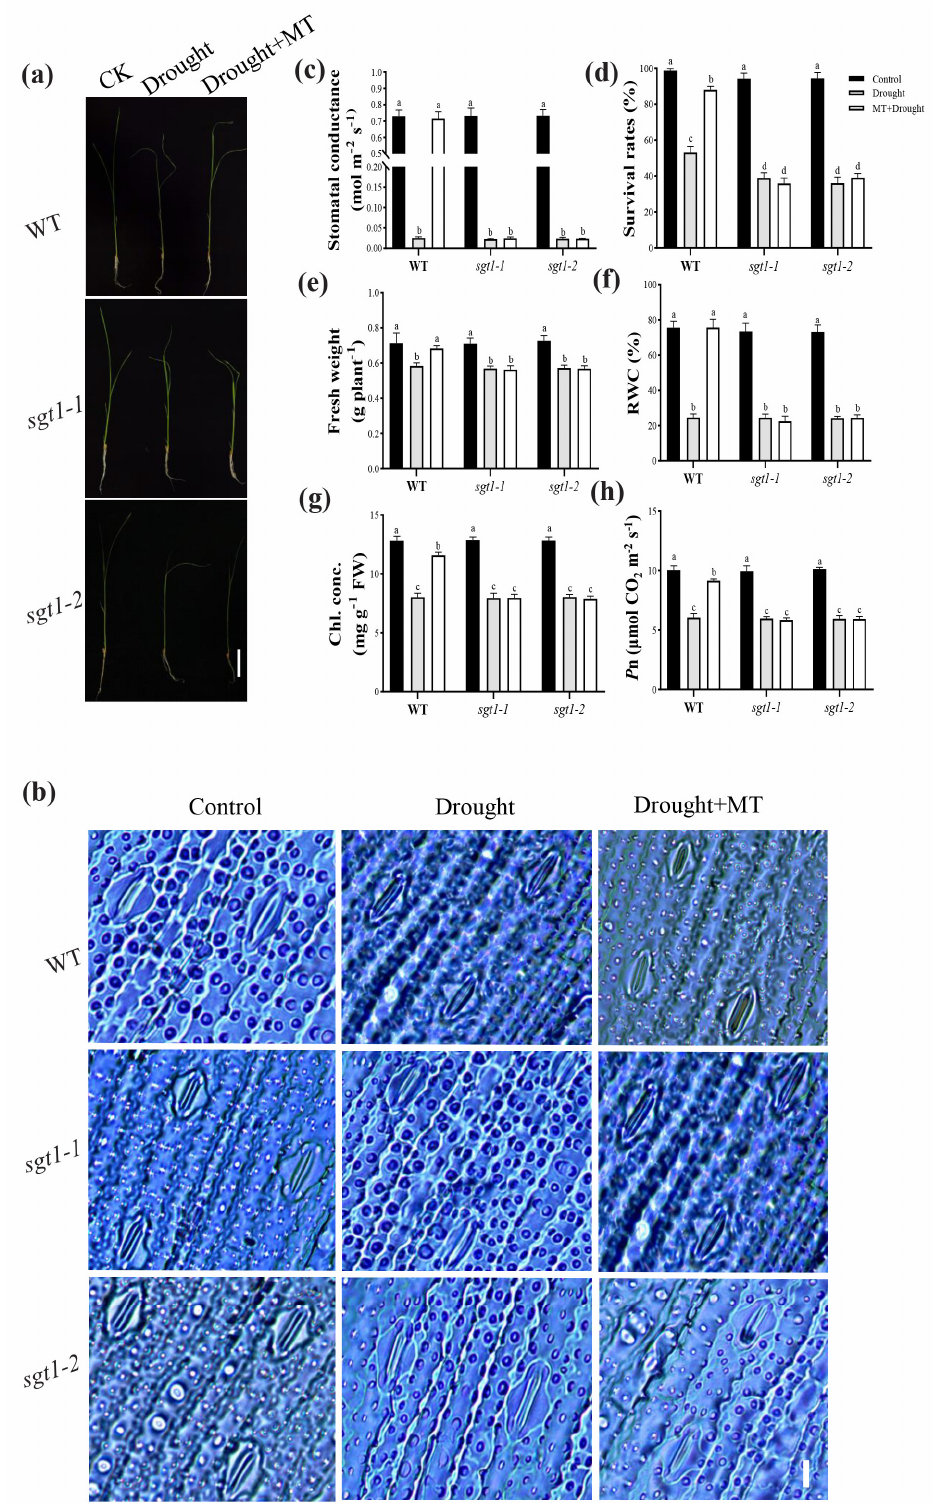
Figure 1. Effects of melatonin treatments on seedling performance under drought stress. ( a ) Plant phenotype, ( b ) stoma phenotype, ( c ) stomatal conductance, ( d ) survival rate, ( e ) fresh weight, ( f ) relative water contents (RWC), ( g ) chlorophyll (Chl) contents, and ( h ) photosynthetic rates ( P n ) were examined in the leaves of wild-type (WT) and sgt1 mutant seedlings treated with melatonin (MT; 100 µ M) under drought stress. Difference in letters indicates significant differences according to Tukey’s Multiple Comparison Test ( p < 0.05). ( a ) Bar = 3 cM; ( b ) Bar = 10 µM.